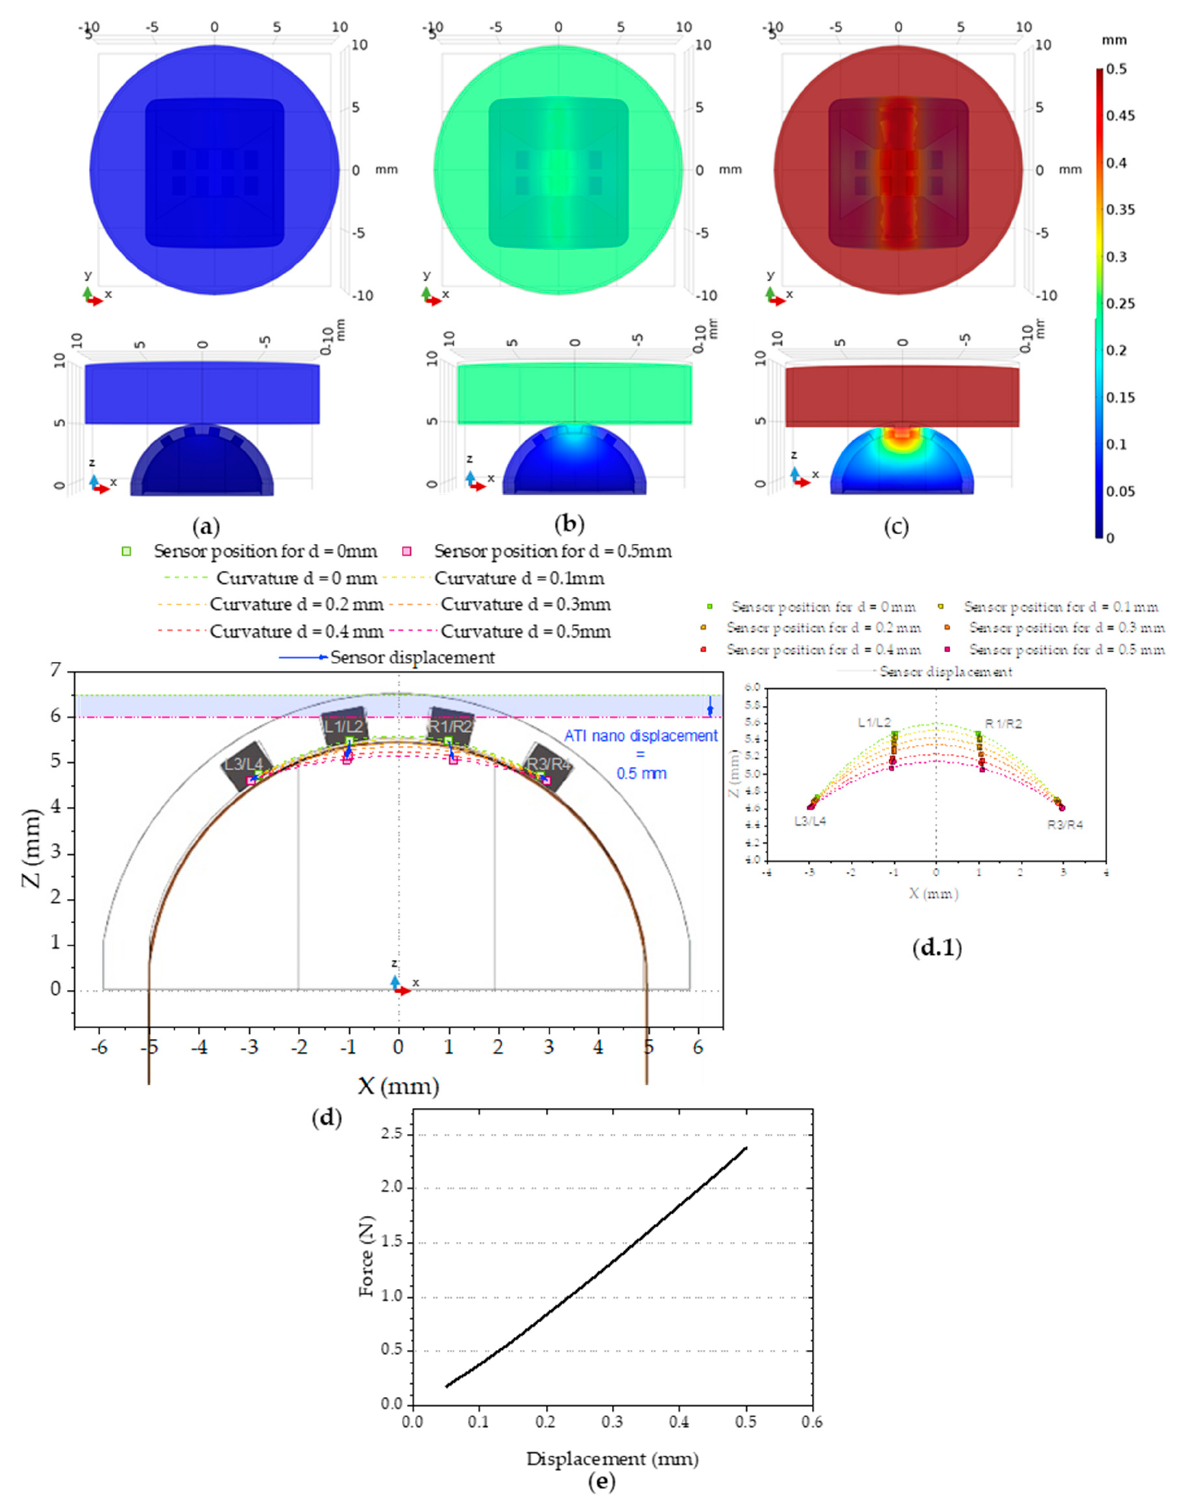
Figure 15. Results of the three-dimensional mechanical simulation detailing the XY plane and ZX plane and showing the displacement results for the steps in color: ( a ) 0.05 mm; ( b ) 0.25 mm; and ( c ) 0.5 mm. ( d ) XZ plane showing the position and displacement of the Si chips. ( d.1 ) Detail of the matrix displacement for each pressing step. ( e ) The force value, obtained by integrating the value of force in each point of the green surface on Figure 14(a.3).